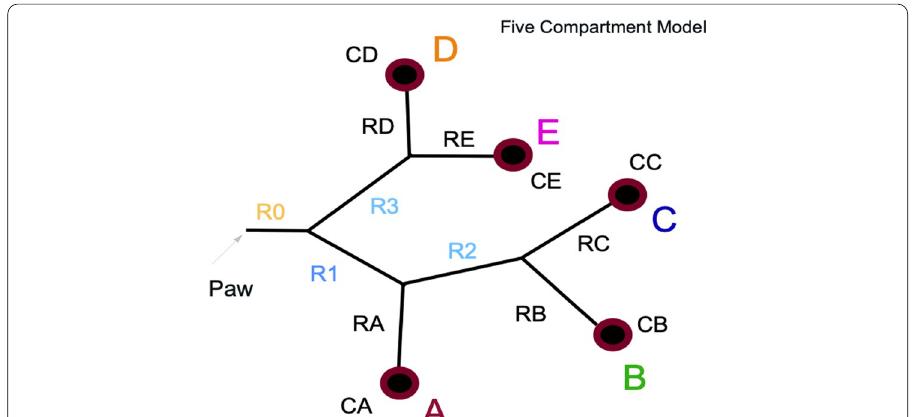
Fig. 1 Schematic diagram of the 5-compartment model. Proximal shared resistances (R) are designated numerically; terminal, compartment-relevant resistances (R) and compliances (C) are designated alphabetically